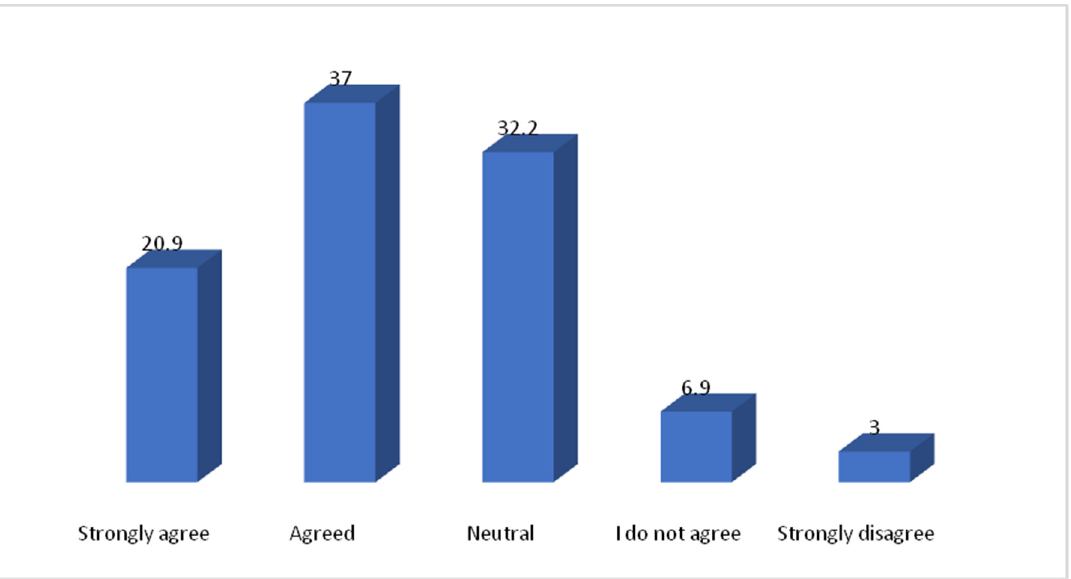
Figure 5. Parents attitude: Is vaccines are generally considered safe? Table 4. Parent’s Perspectives on the COVID-19 Vaccine and their concern toward children’s